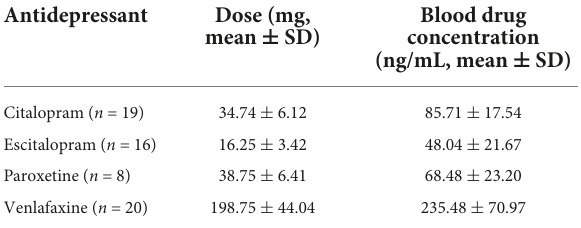
TABLE 2 Average dosage and blood drug concentration of antidepressants.